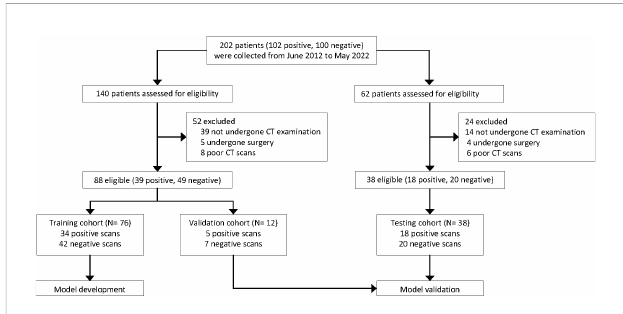
FIGURE 1 Flow chart showing the overall study process. All computed tomography (CT) scans were retrospectively collected from the clinical databases of a single